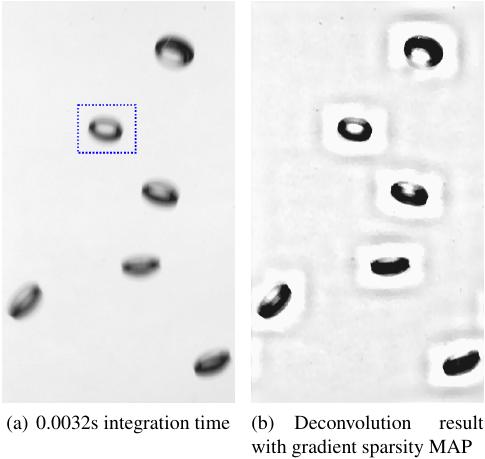
Figure 7: Strong motion blur image and gradient sparsity decon- volution with changed weighting on the regularization allowing a more flexible blur kernel. The dotted blue rectangle shows the cropped segment of Figure 8.